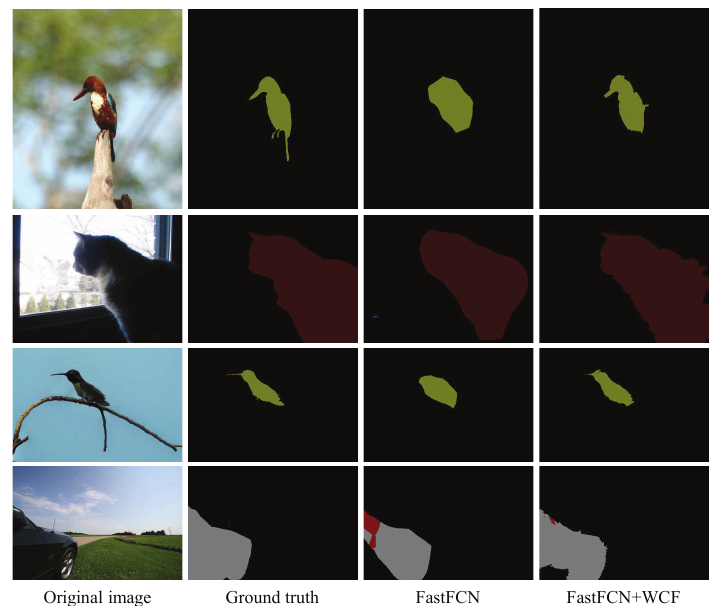
Figure 5. Enhancement of segmentation results of FastFCN. From the first row to the fourth row are bird, cat, bird and car, respectively. From the first column to the fourth column are the original images, the ground truth of images, the preliminary segmentation results by FastFCN and enhancement results by the proposed methods FastFCN+WCF.